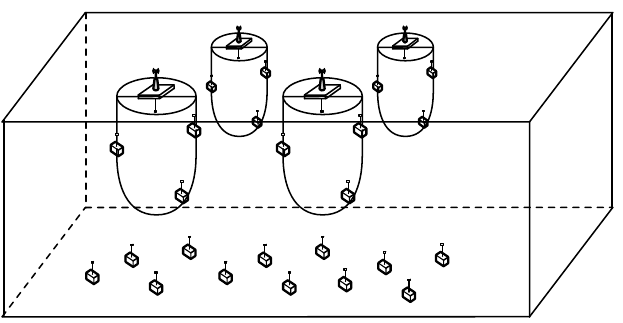
Figure 5. Simulated scenario